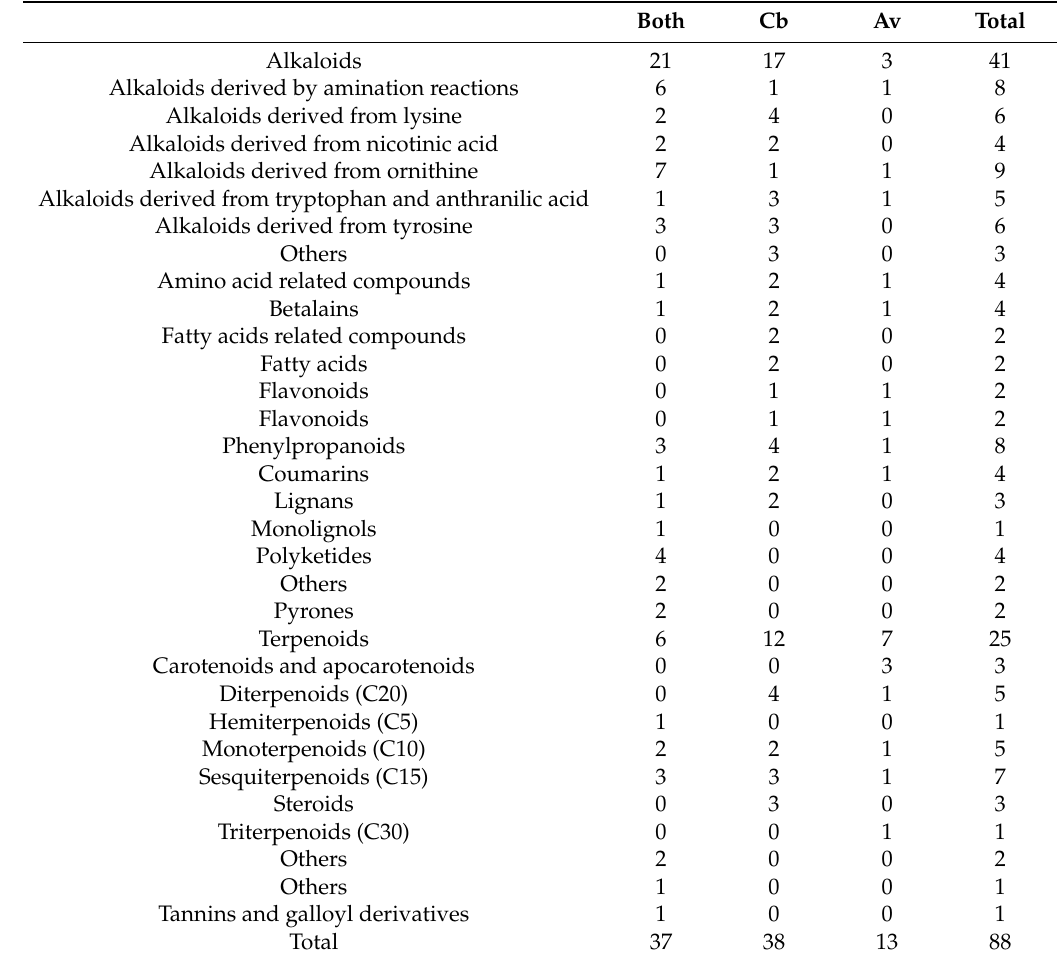
Table 5. Distribution of Secondary Metabolites as detected in each of the growth conditions of cellobiose (Cb) and Avicel